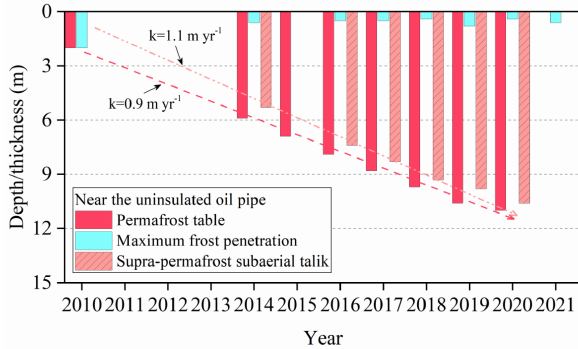
Figure 8. Variations in the depths of permafrost table and seasonal frost, and thickness of supra-permafrost subaerial talik (SST) during 2010–2021 in borehole JB-B-1, 2m away from the centerline of the uninsulated China–Russia crude oil pipeline (CRCOP) I at the JB site in the northern part of Northeast China, where k denotes the increasing